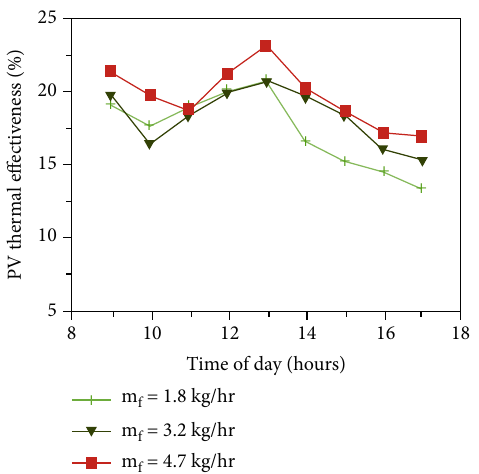
Figure 15: E ff ect of the water mass fl ow rate on the PV thermal e ffi ciency during a day [66].